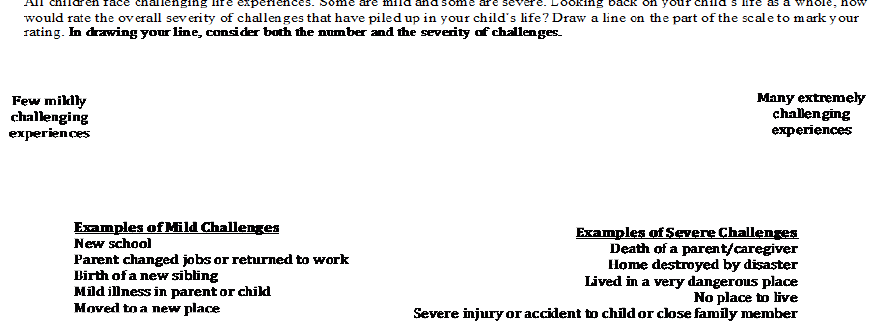
Figure 2. The Child Life Challenges Scale (paper-pencil